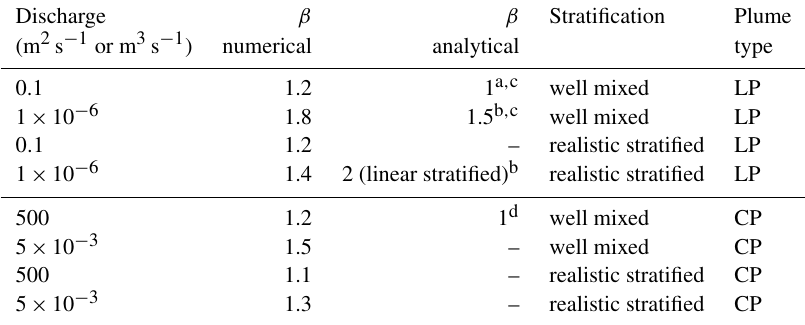
Table 3. Numerical determination of the power law β for a melt rate dependence of m ∝ (cid:49)T β a with the thermal forcing (cid:49)T a = T a − T af for tidewater glaciers. The exponent was derived for the LP and CP model for lower and higher discharge ranges. A comparison to an analytically derived value of β for limiting discharge (low and high) ranges from literature and our study is listed for some cases additionally. Discharge β β